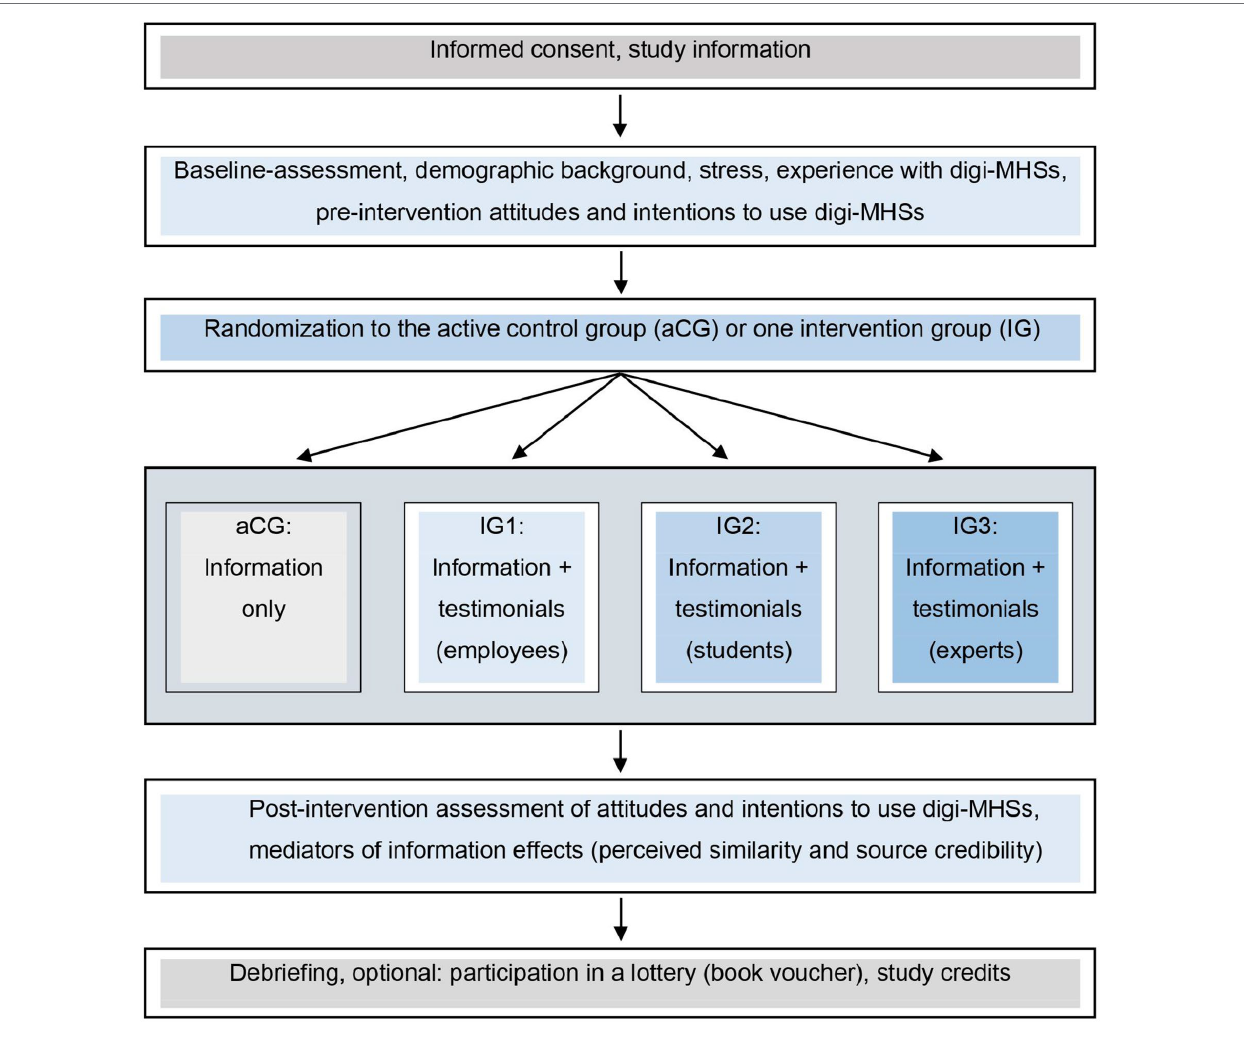
FIGURE 1 | Study flow chart. Procedure of the online experiment comparing attitudes and intentions to use digital mental health interventions (digi-MHSs) between three narrative intervention groups (IGs) receiving information plus various testimonials and the active control group (aCG) receiving information